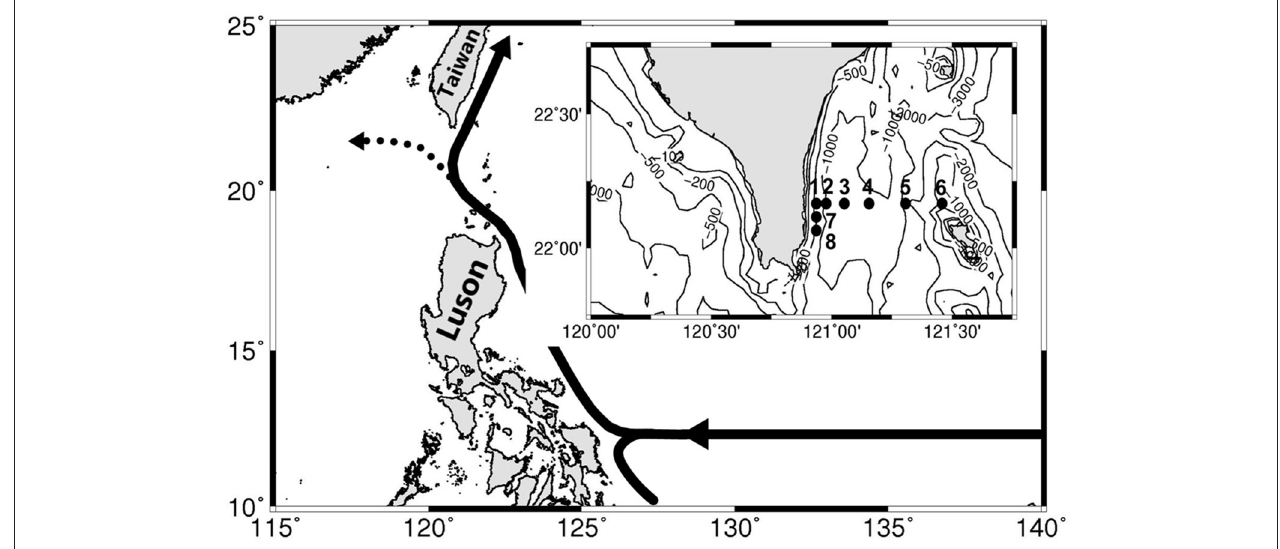
FIGURE 1 | Map of southern Taiwan shows the sampling stations across the mainstream of the Kuroshio. The isovalue lines of bottom depth are also shown. Diel sampling was conducted at stations 2 and 6. The solid and dashed lines with arrows in the upper-left corner indicate the axes of the Kuroshio mean